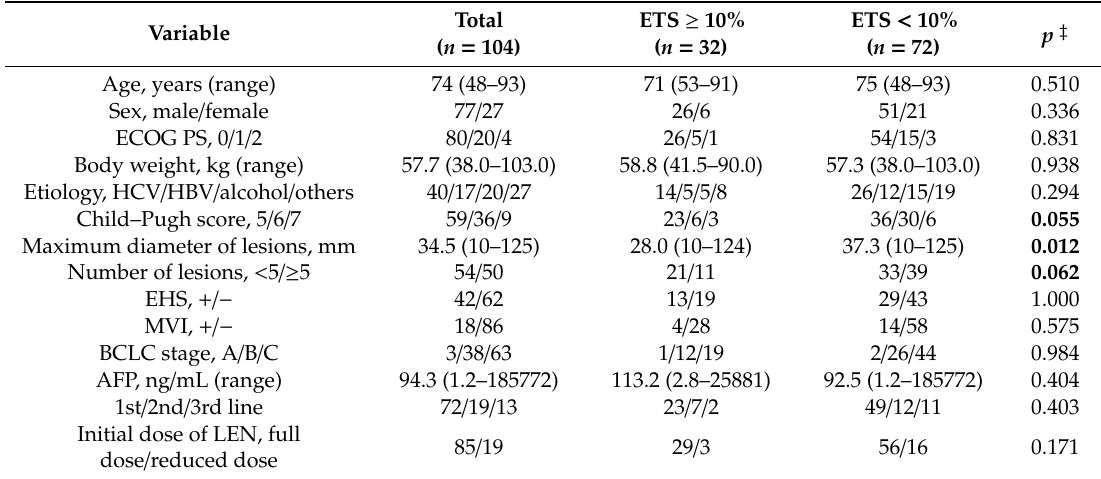
Table 1. Baseline patient characteristics, according to early tumor shrinkage ( n = 104) † .